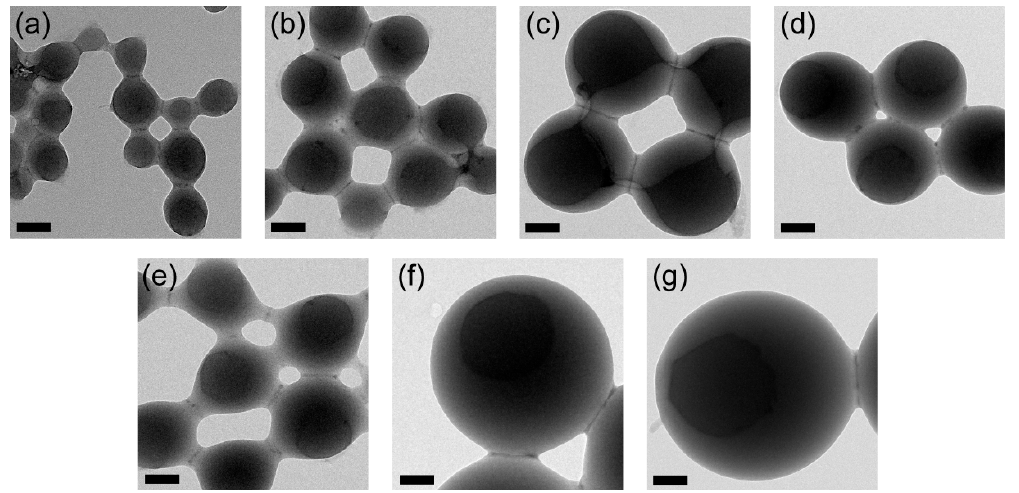
Figure 1. Transmission electron microscopy (TEM) images of poly(methacrylic acid) cross-linked with ( a ) 40 mol% EGDMA, ( b ) 20 mol% DEGDMA, ( c ) 20 mol% TEGDMA, ( d ) 20 mol% TETEGDMA, ( e ) 30 mol% DEGDMA, ( f ) 40 mol% DEGDMA, and ( g ) 45 mol% DEGDMA. Scale bars = 100 nm.